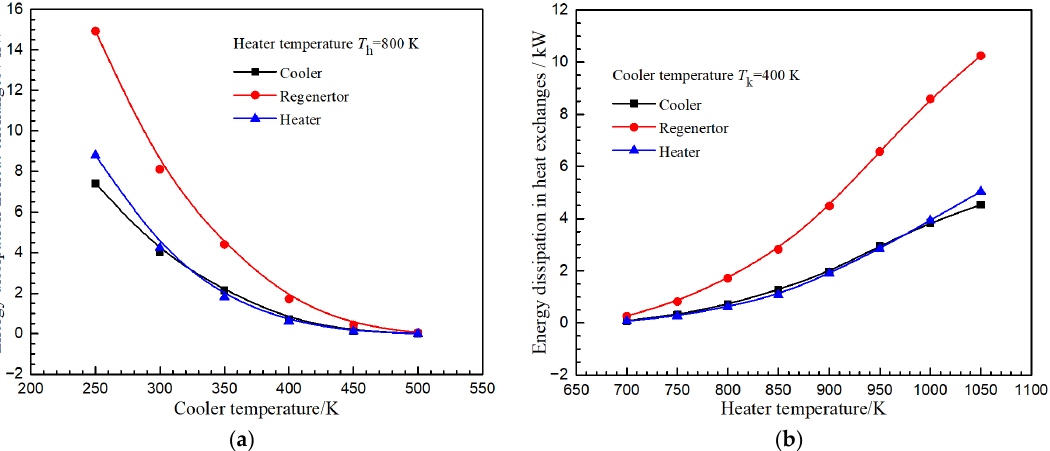
Figure 13. the effect on energy dissipation: ( a ) effect of cooler temperature, ( b ) effect of heater temperature.